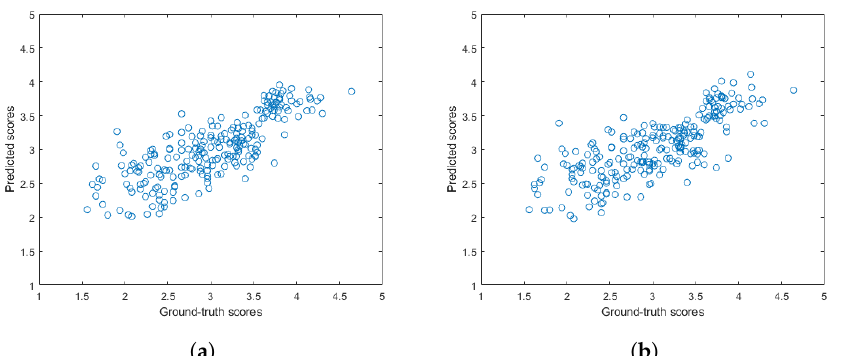
Figure 8. Scatterplots of the ground-truth versus the predicted quality scores on a KoNViD-1k [16] test set when using the pooling of individual regressors’ scores as a regression strategy: ( a ) average pooling, ( b ) median